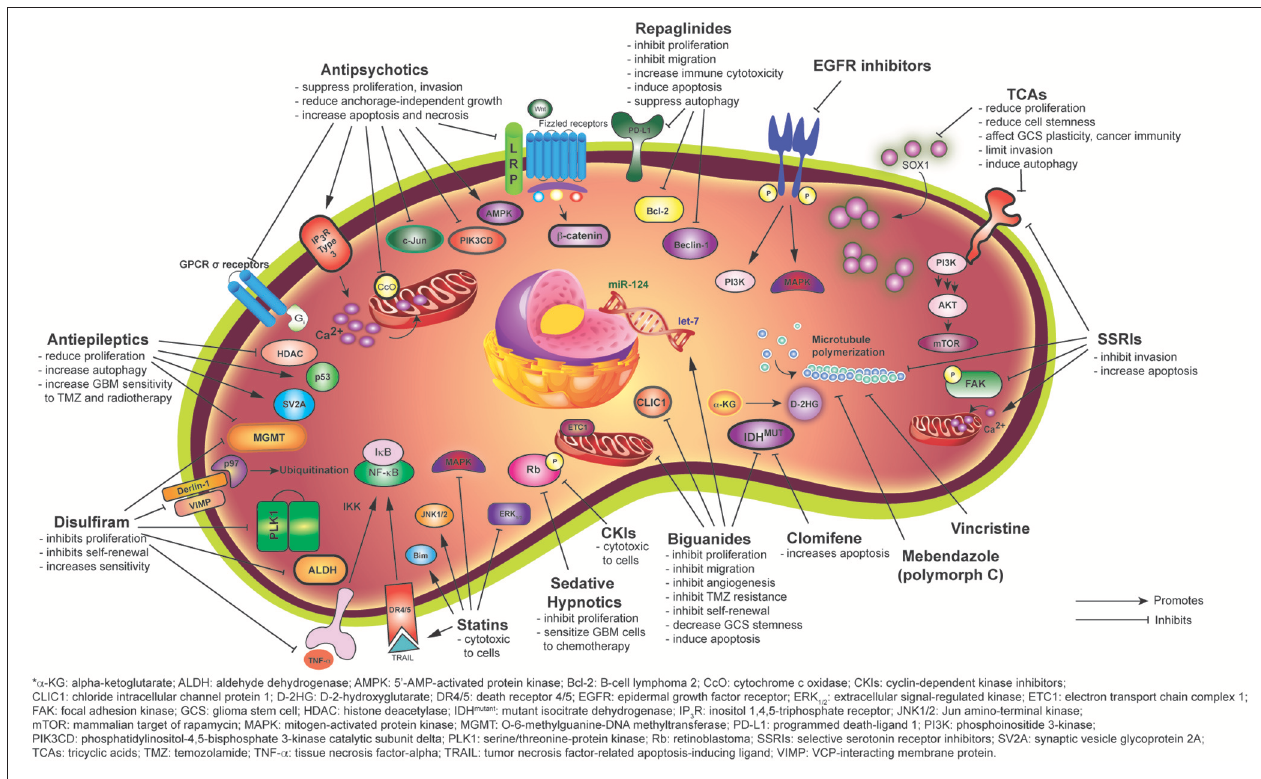
FIGURE 1 | Mechanisms of anti-gliomagenic effects of different psychiatric and non-psychiatric drugs as demonstrated via in vitro